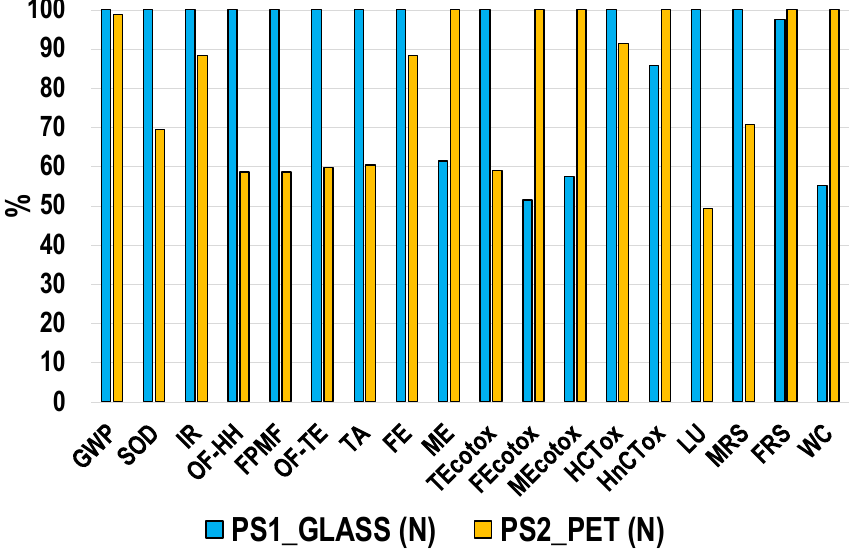
Figure 2. Comparison between the life cycle impacts of the considered packaging systems (PS1_GLASS and PS2_PET) for the natural drinking (N) water.